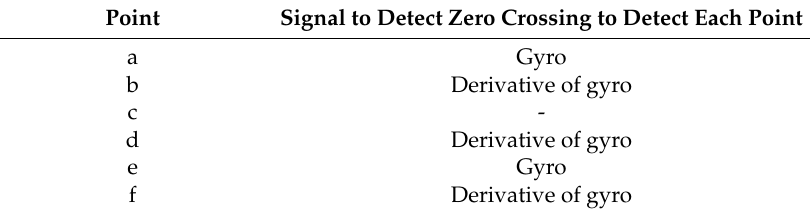
Table 3. Signal feature that can be used to detect each point of the stride cycle.